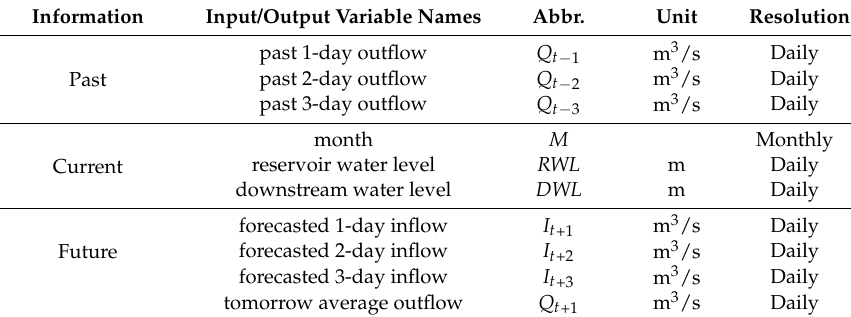
Table 1. Detailed information of model input and output